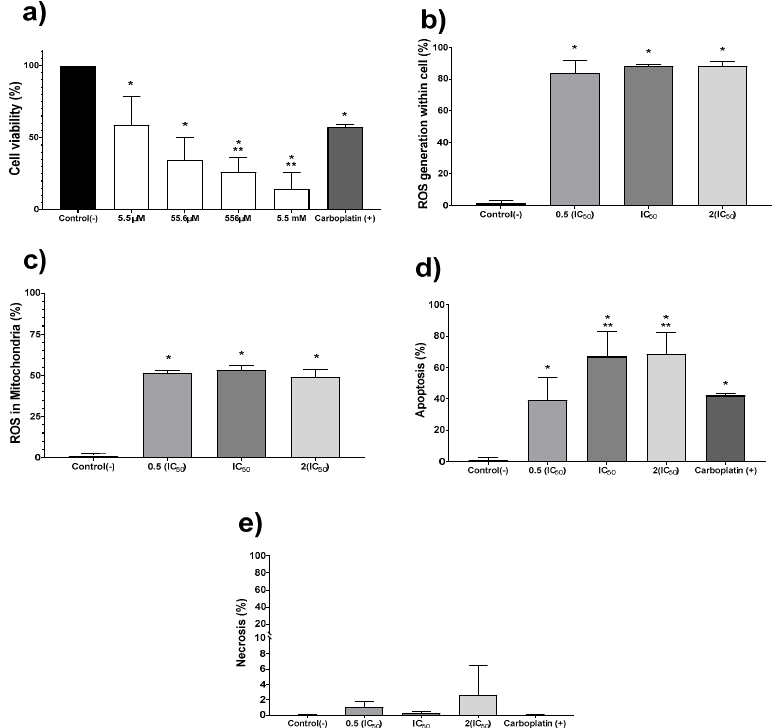
Figure 2. Silver nanoparticles (AgNPs) antiproliferative activity on human adenocarcinoma HCT- 15. Cell viability ( a ) was determined using 5.5µM, 55.6 µM, 556.2 µM, and 5.5 mM (0.6, 6, 60 and AgNPs. ( b ) Apoptosis, ( c ) necrosis, ( d ) reactive oxygen species (ROS) overproduction within the cell, and ( e ) ROS overproduction inside mitochondria were determined using half of the IC 50 , IC 50 , and double of the IC 50 . The * represents a significant difference ( p ≤ 0.001) compared with negative control, ** represents a significant difference ( p ≤ 0.001) compared with